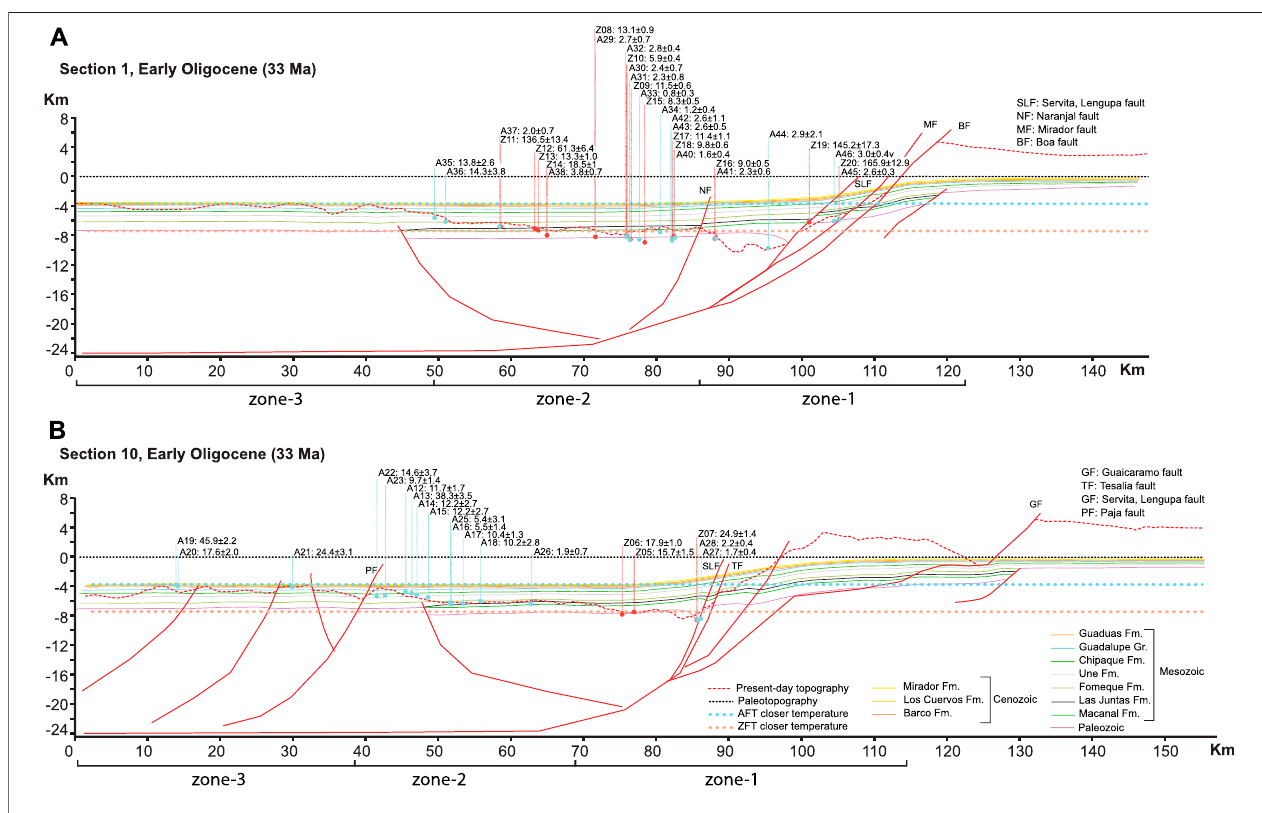
FIGURE 11 | Restoration to ∼ 33 Ma, (A) of Section 1, (B) of Section